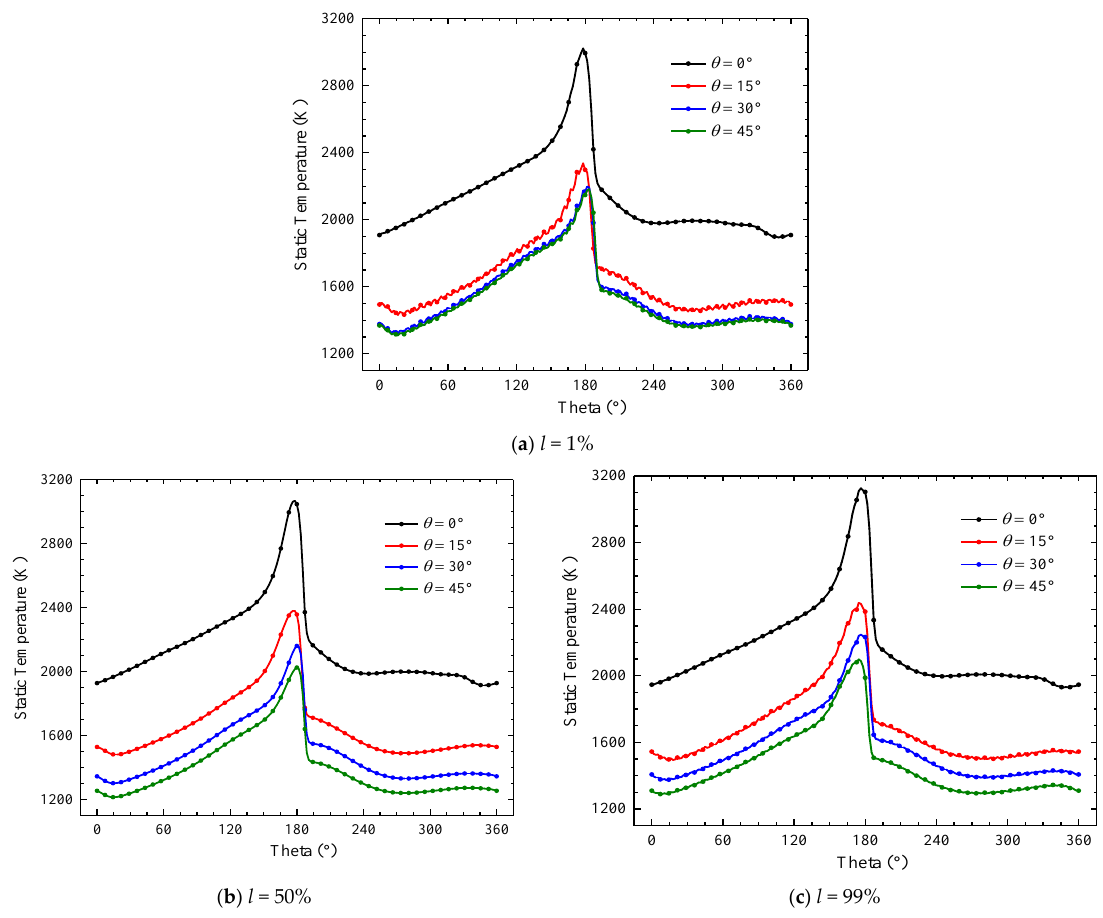
Figure 21. The circumferential outlet static temperature distribution of RDC at t = 3980 μs.